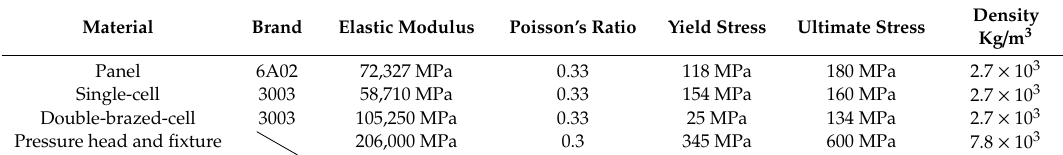
Table 2. Material parameters of honeycomb.